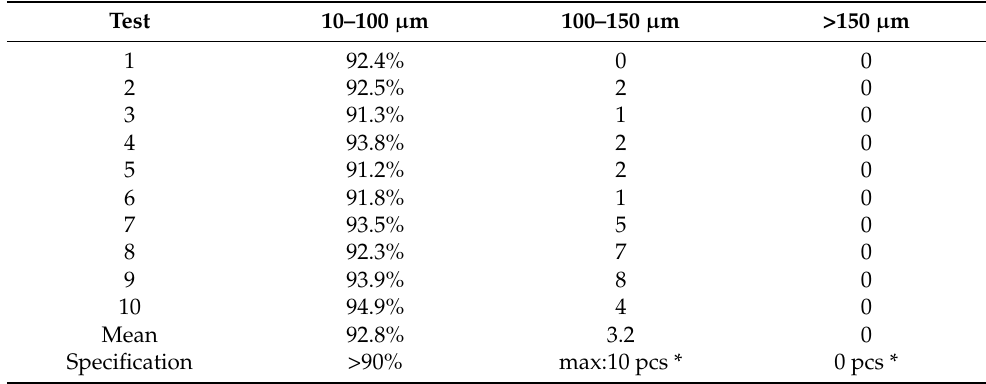
Table 1. Particle size determination by Medi-Radiopharma, Hungary on the problem cumbered [ 99m Tc]Tc-Makro-Albumon batch by a microscopic analysis of the contents of ten labelled kits.